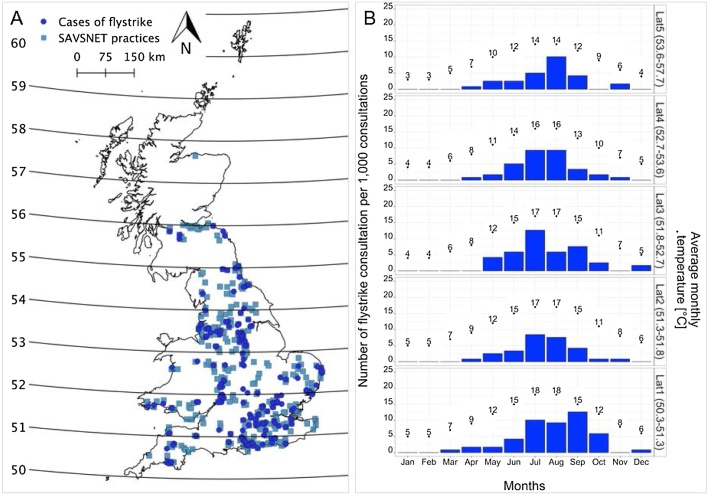
A: Distribution of blowfly strike cases across GB according to the longitude and latitude of the owner’s postcode. B: Percentage of blowfly strike cases in each month in each latitudinal quintile (Lat1 (50.3–51.3 degrees), Lat2 (51.3 to 51.8), Lat3 (51.8 to 52.7 degrees), Lat4 (52.7 to 53.6 degrees) and Lat5 (53.6 to 57.7 degrees)) and the average temperature per month in each quintile.